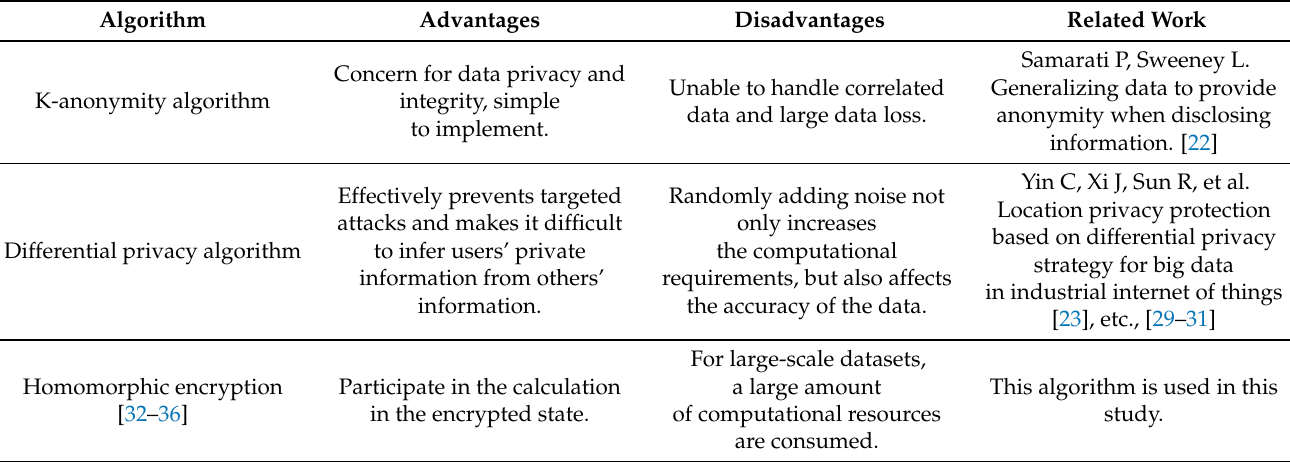
Table 2. Advantages and disadvantages of location privacy-related